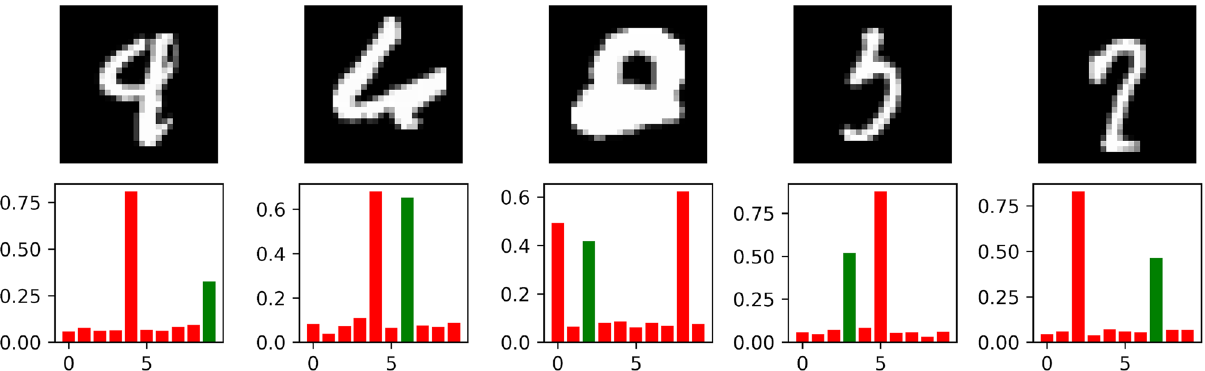
Figure 6. Example of Efficient-CapsNet misclassified digits. Green bars represent correct labels and their high the corresponding capsule length. The ambiguity of these remaining questionable examples is reflected in the uncertainty of the network predictions.